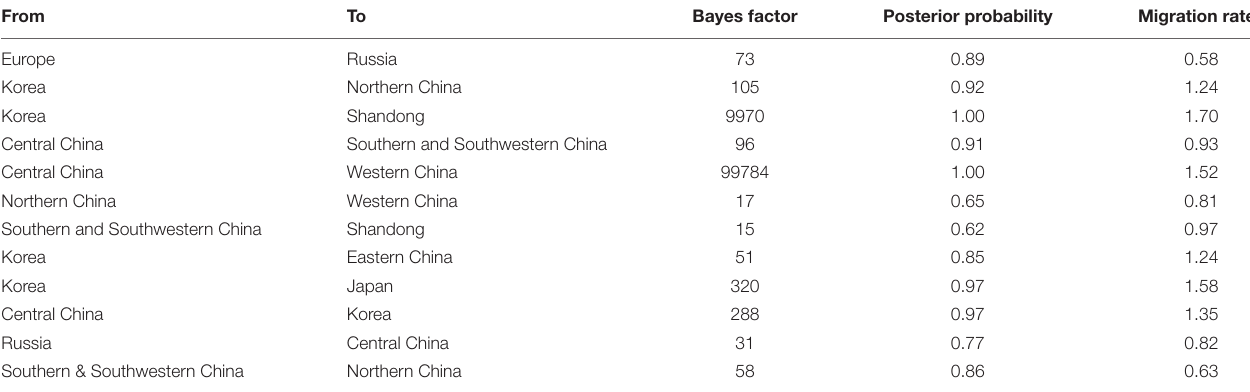
TABLE 2 | Statistically supported Bayes factors and migration rates of clade 2.3.4.4b H5N8 viruses during 2020–2021 estimated from HA gene sequences. From To Bayes factor Posterior